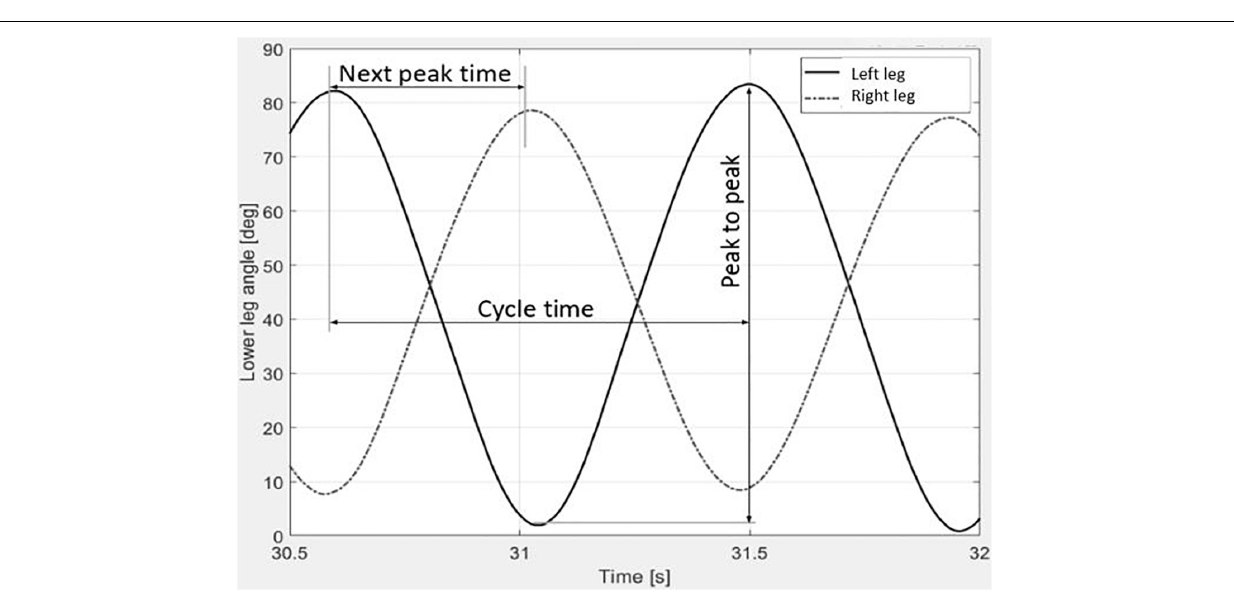
FIGURE 2 | Visualization of movement cycles of left and right leg of a person with